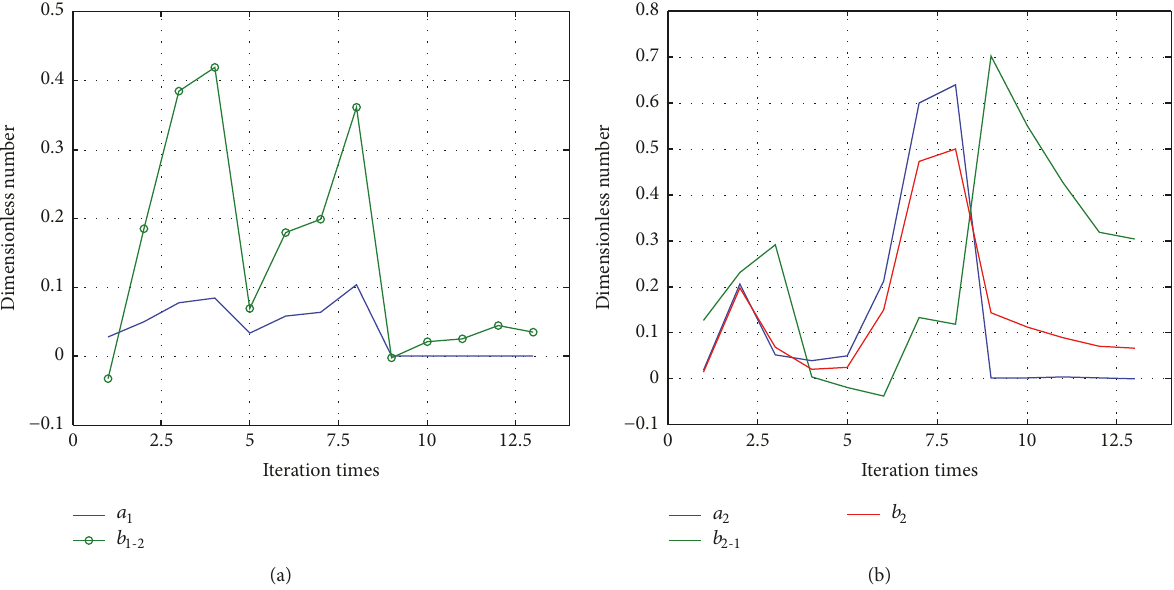
Figure 8: Changes of parameters in incremental learning algorithm: (a) parameters in the left tank and (b) parameters in the right tank.